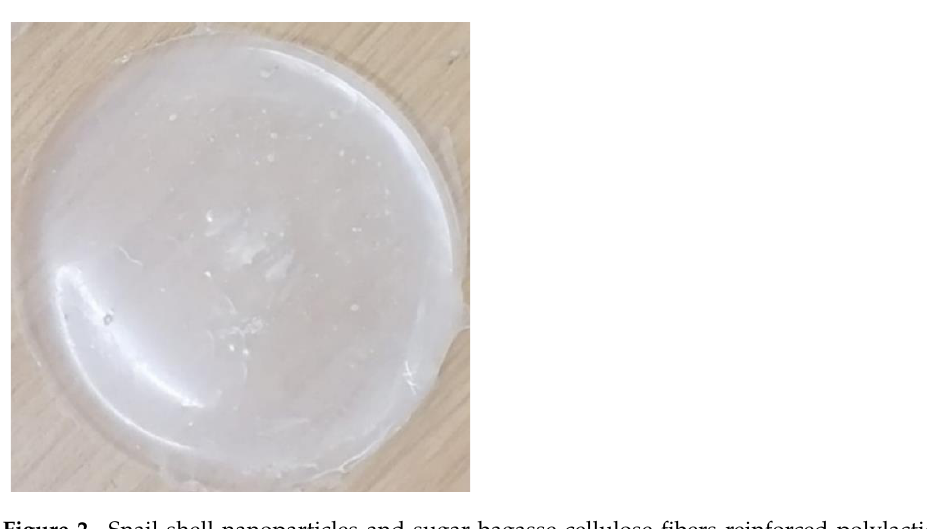
Figure 2. Snail shell nanoparticles and sugar bagasse cellulose fibers reinforced polylactic acid bioplastic film.